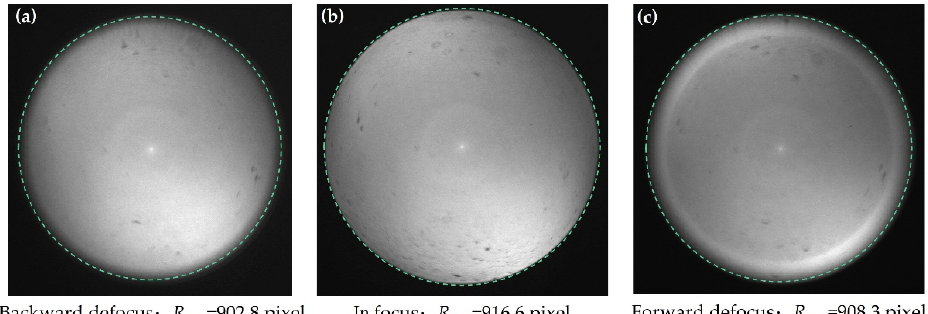
Figure 2. Maximum BFP image radii of a 44.34 nm SiO 2 film at different defocus positions and its blurring and distortion: ( a ) a backward-defocused BFP image near the objective lens; ( b ) an in-focus BFP image; ( c ) a forward-defocused BFP image far from the objective